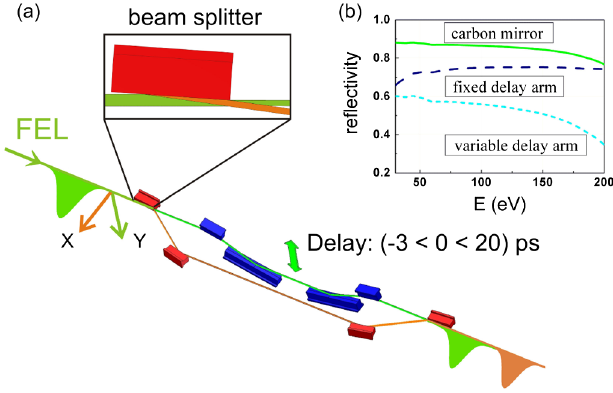
FIG. 1. Scheme of the autocorrelator. (a) The FEL pulse is divided by the wave front beam splitter. One partial beam is reflected horizontally into a fixed arm of the autocorrelator, the other partial beam passes the beam splitter and is vertically reflected into the delay stage. With the last mirror the beams are recombined. Different overlap angles on a CCD camera can be set by rotating the last mirror. (b) The reflectivity of a carbon coated silicon mirror is shown as a function of photon energy (green line). The dashed lines represent the total transmission of the fixed (dark blue) and the variable delay arm (light blue).